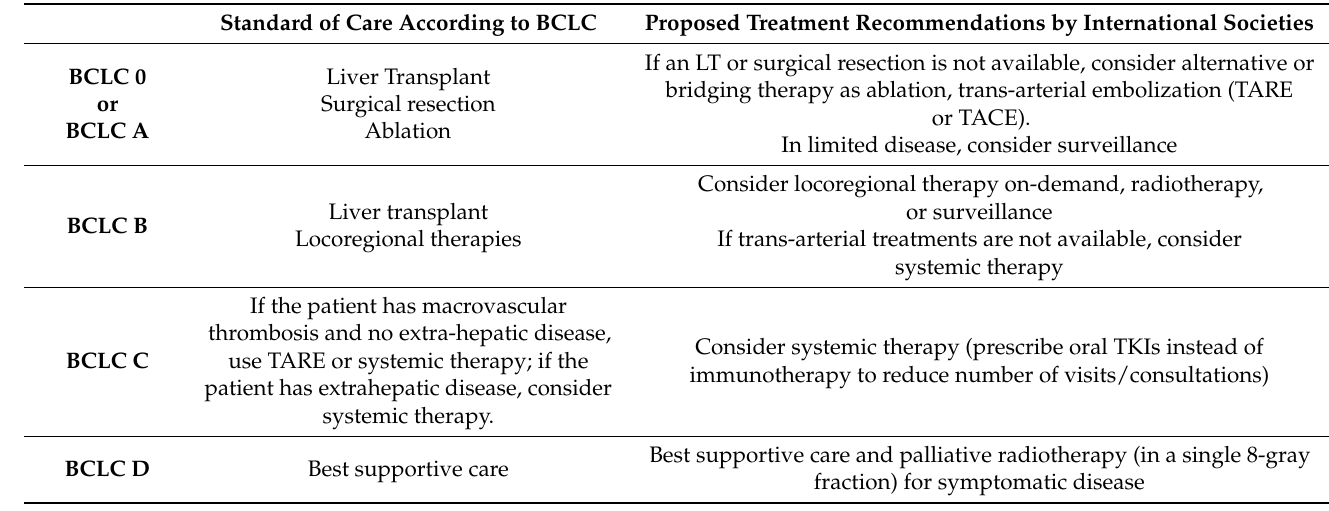
Table 3. Proposed treatment recommendations by international societies according to the BCLC (Bercelona Clinic Liver Cancer)